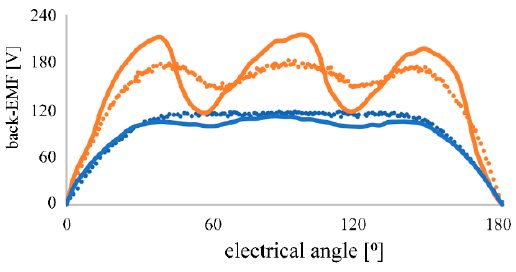
Figure 11. RMS of induced experimental (dotted line) and simulation voltages (solid line) in no-load machine for I DC = − 5 A (blue) and I DC = 5 A (orange).